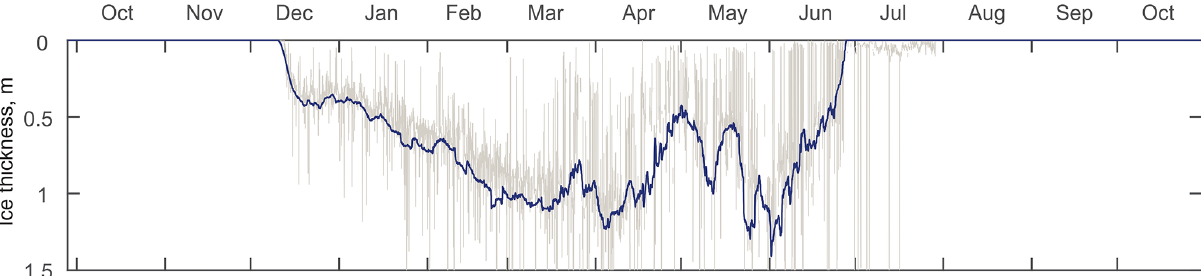
Figure 2. ADCP-measured ice thickness at the mooring location (AN01) during winter 2016–2017. Gray and blue lines represent the filtered and daily averaged ice thicknesses,